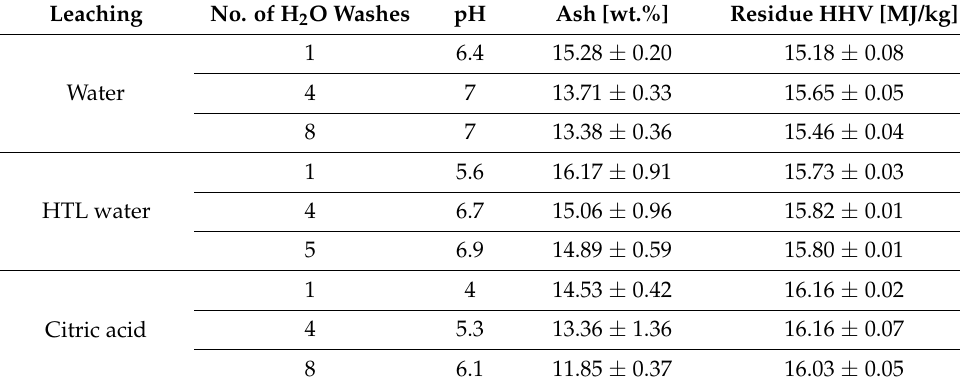
Figure 1. Correlation between macroalgae residue and ash content post demineralization. Table 1. Demineralization results, highlighting the effects different leaching agents and post- treatment via water washing have on the pH, final ash content and higher heating value of macroalgal biomass.